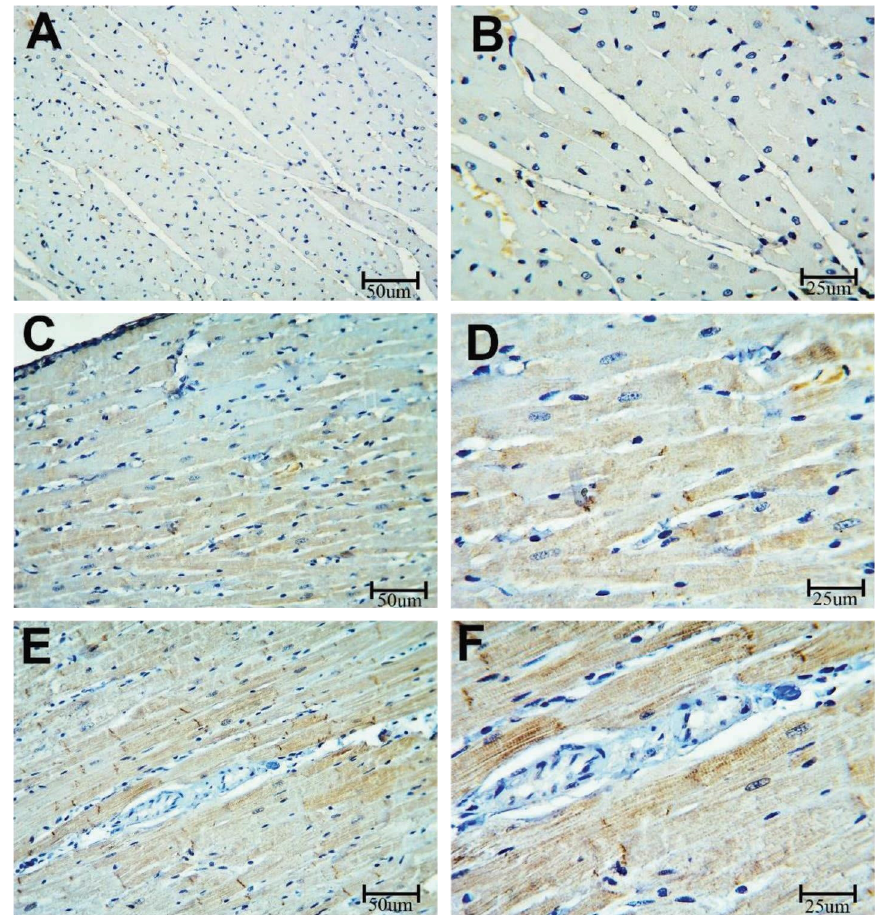
Figure 10: Histopathological section in the heart of rat stained with eNOS immune stain. a and b are the control group, c and d are the BPA group, and e and f are the BPA +LC group. Te cardiac muscle of the control group shows a minimal expression of the dye in the wall of the artery. Te expression of the color is notably increased in the BPA group and reduced in the BPA+ LC group (eNOS immune stain; A, C, and E X 200; B, D, and F X 400).